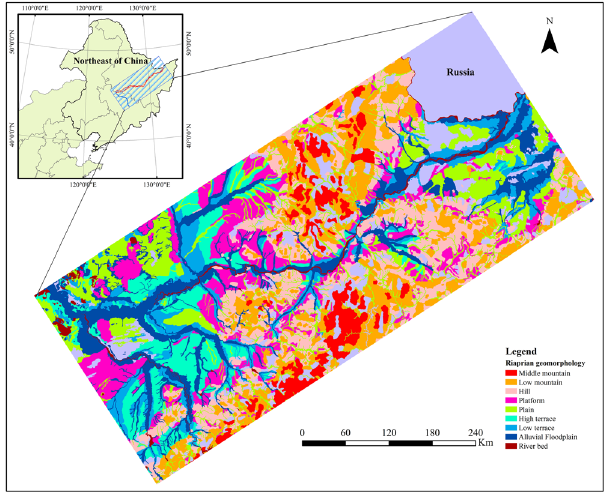
Figure 3. This figure illustrates an example of 1:500,000 geomorphic map for the riparian zone. The categories include Middle mountain, Low mountain, Hill, Platform, Plain, High terrace, Low terrace, Alluvial Floodplain and River bed. ArcGIS 10.3 software (http://www.esri.com/software/arcgis) was used to process and map the data by first author (B.